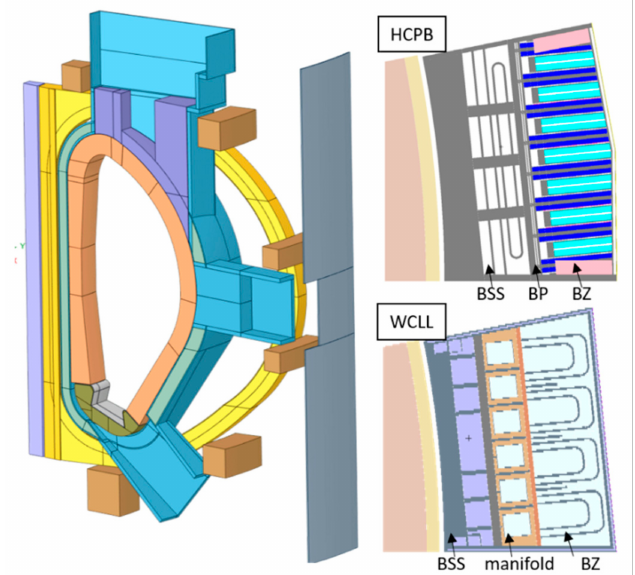
Figure 1. Envelop blanket design of DEMO ( left ), the MCNP model of HCPB ( top right ) and WCLL fully heterogeneous breeder blanket design ( bottom right